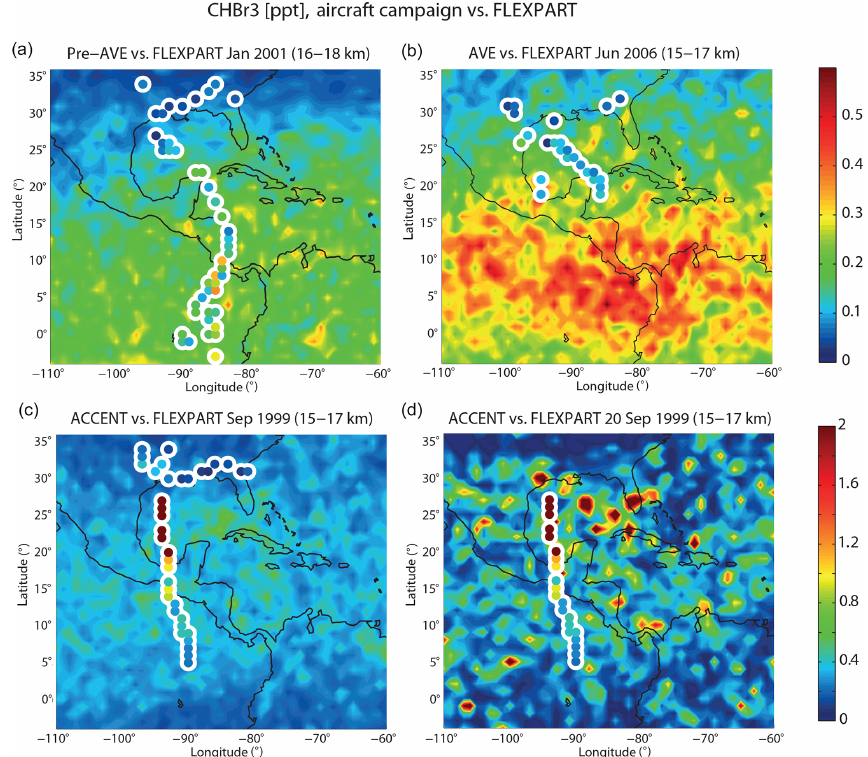
Figure 3. Modelled distribution of CHBr 3 in the upper TTL from FLEXPART (background colouring) in comparison with aircraft campaign measurements (coloured symbols with white edges). In (a) , (b) , and (c) , all individual measurements from the respective campaign and the model mean over the same time period are shown. Only in (d) is one individual flight (ACCENT flight from 20 September 1999) shown together with FLEXPART daily mean values to illustrate the large spatial variability including maximum values ≥